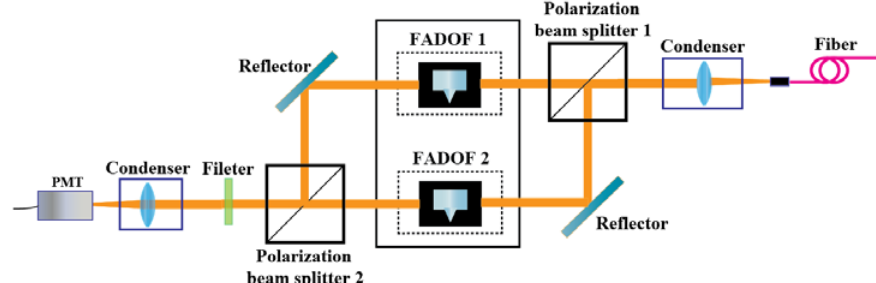
Figure 3. Optical path schematic of the dual -channel FADOF.